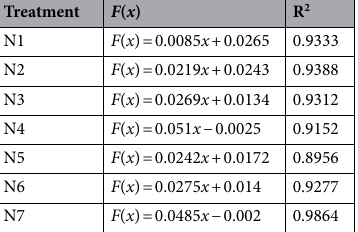
Table 4. Functional relationships between water flow power ( W ) and soil separation rate ( Dr ). W is water flow power, Dr is soil separation rate.